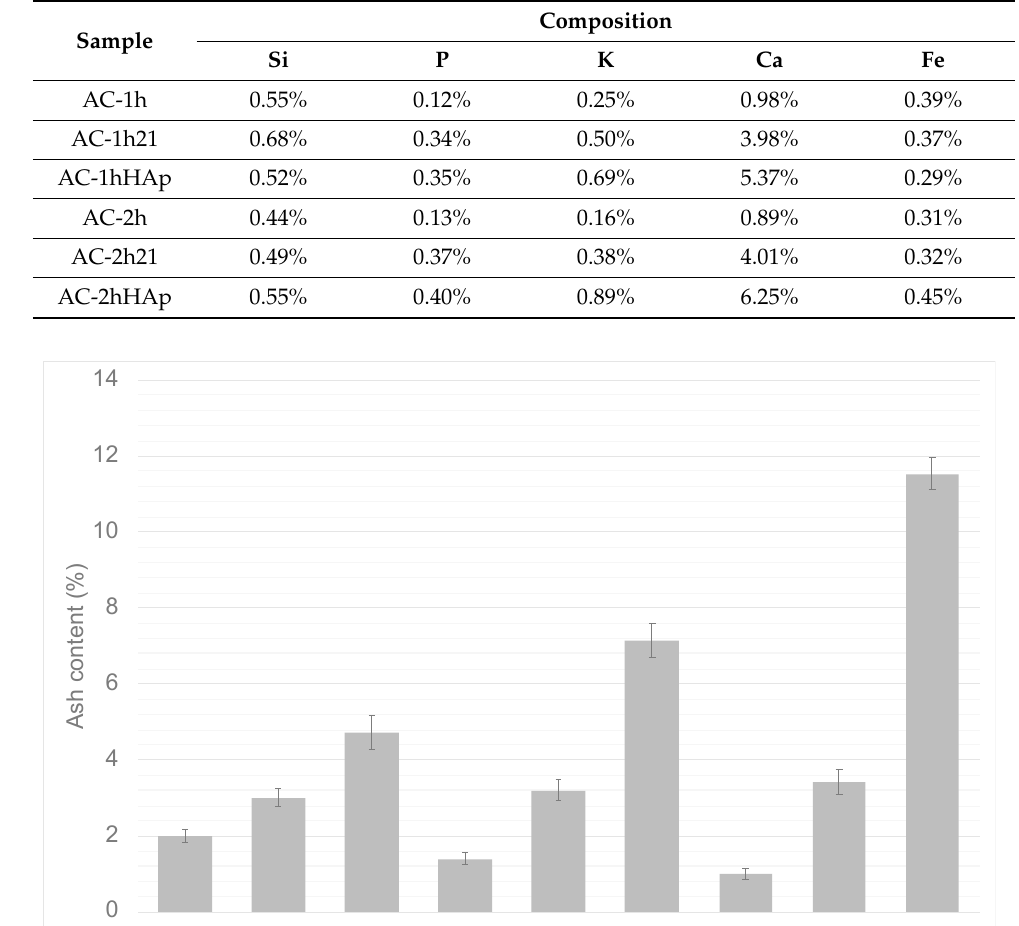
Table 1. Compositions of carbon ‐ based materials.